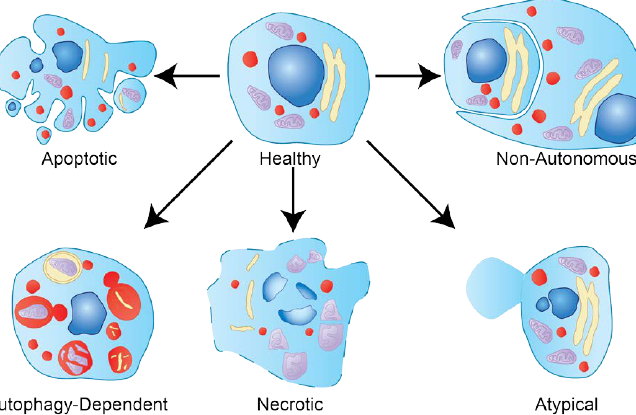
Figure 2. Types of cell death. Diagram of a healthy cell dying by each of the five different classifications of cell death. The apoptotic cell exhibits characteristic blebbing and nuclear fragmentation. Autophagy- dependent cell death is illustrated with numerous acidified compartments and double-membraned vesicles. Necrotic cell death displays plasma membrane lysis and organelle swelling. The atypical form of cell death shown here is pyroptosis; a large pore has formed and plasma membrane contents are spilling out. The non-autonomous cell death demonstrated is phagoptosis, where the phagocyte is utilizing phagocytosis machinery to engulf and eliminate a nearby cell.